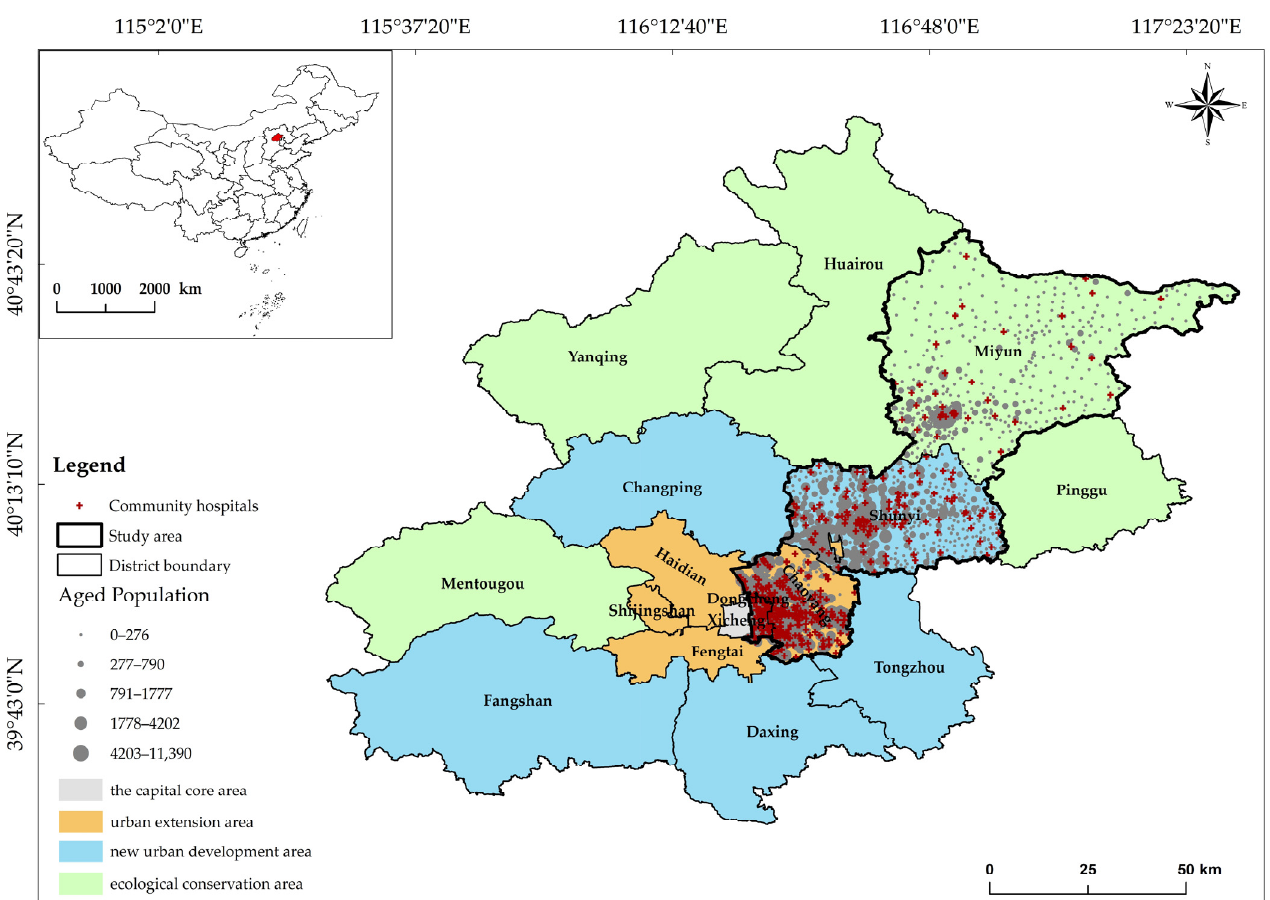
Figure 2. Distribution of community hospitals and the aged population in the study areas in Bei-